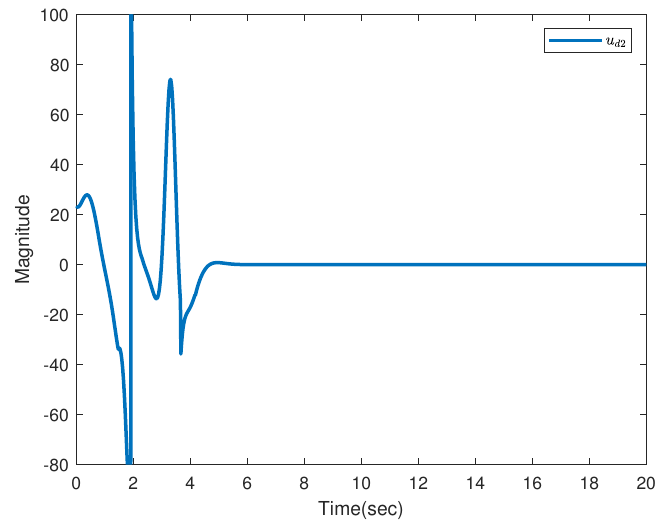
Figure 3. Time history of the control input u d 2